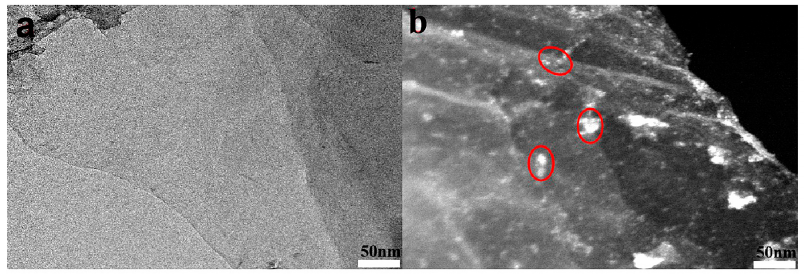
Figure 4. TEM images of ( a ) GO, ( b ) STG.